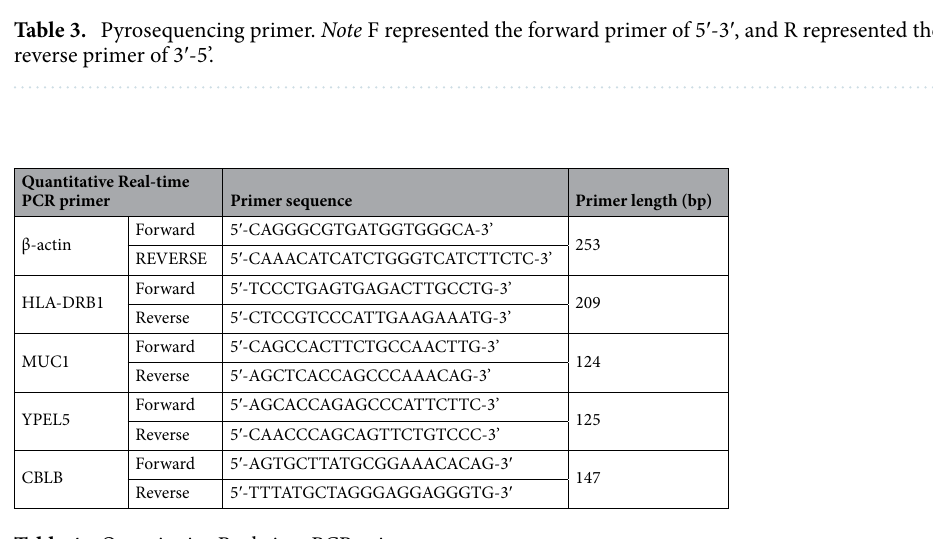
Table 4. Quantitative Real-time PCR primers.